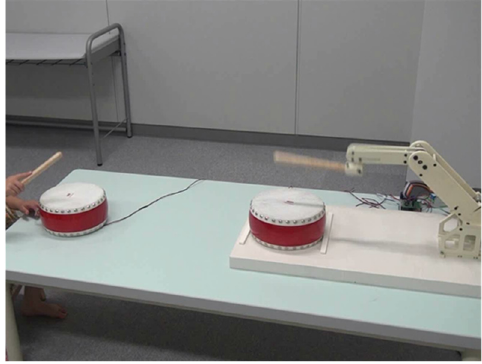
Figure 5. The drumming robot with a robot arm.